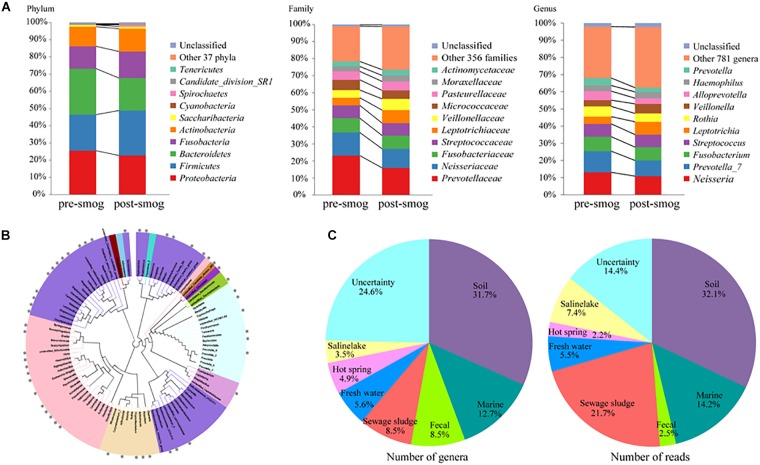
The pharyngeal microbiota composition diversity was affected by smog. (A) The pharyngeal microbiota composition diversity at the phylum, family, and genus levels. (B) The top 100 most abundant genera between the pre- and post-smog data. The sizes of the nodes correspond to the relative abundance at the corresponding levels in the cohort. (C) The origins of 142 new bacterial genera detected only in post-smog samples.